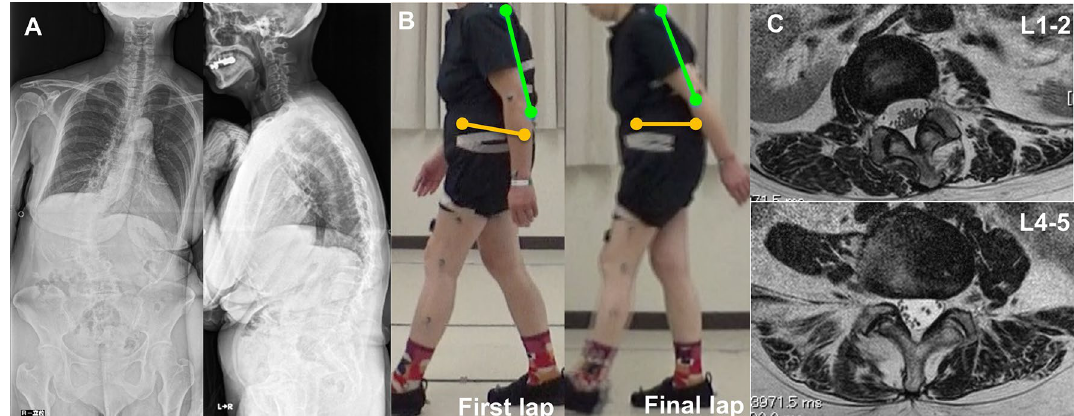
Figure 4. A representative case of a 63-year-old female patient with almost normal TK and increased PT, large fat infiltration rate of the lumbar erector spinae muscles and an increase of spinal kyphosis and pelvic anteversion. ( A ) Full-spine radiographs. SVA: 89 mm, TK: 40°, LL5.8°, PT 35°, PI: 39° ( B ) Posture during the three-dimensional gait motion analysis on the first and final laps. ΔSpA: 2.5°, ΔPA: 3.1° ( C ) T2 weighted axial MRI images at L1-2 and L4-5. The fat infiltration rate of the lumbar erector spinae muscles (L1-2: 15% and L4-5: